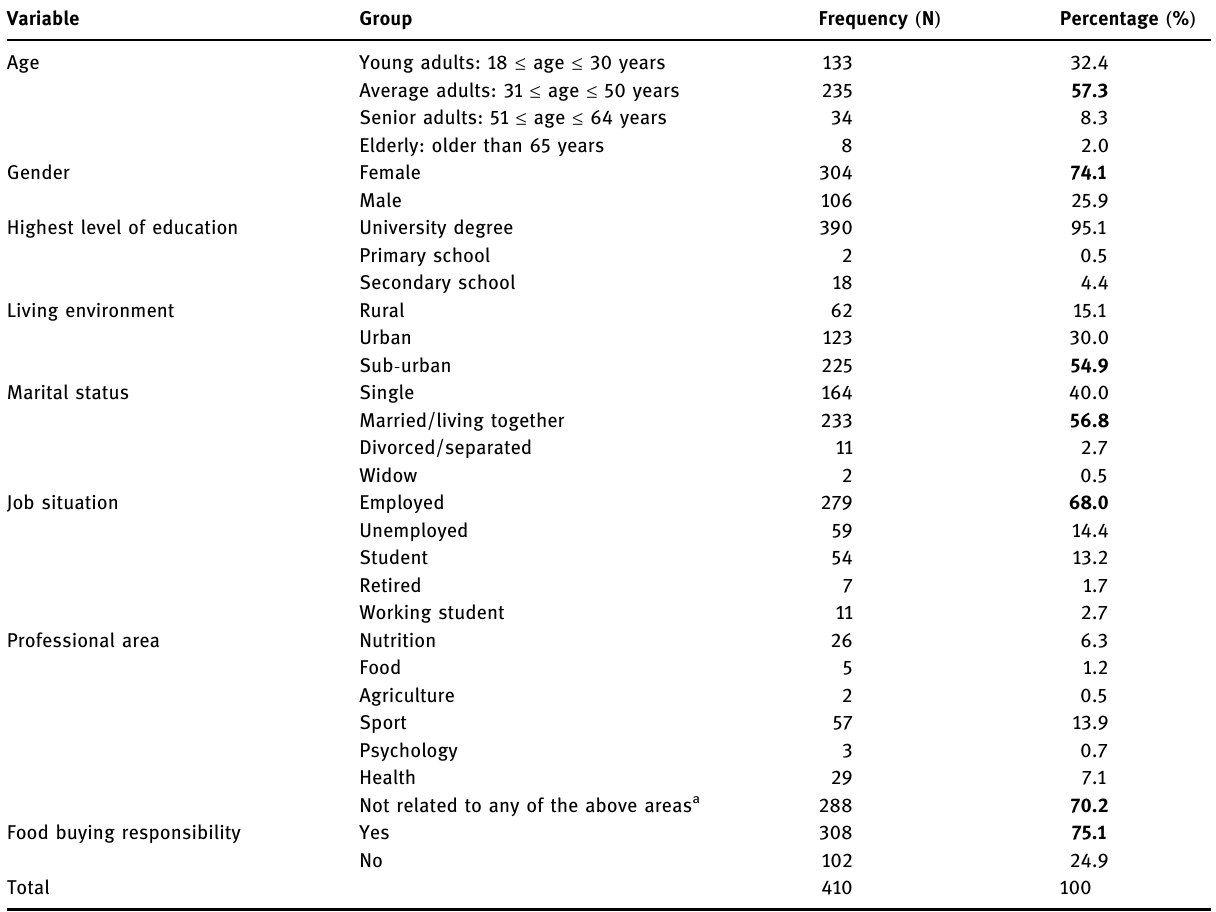
Table 1: Sociodemographic characterization of the sample studied.